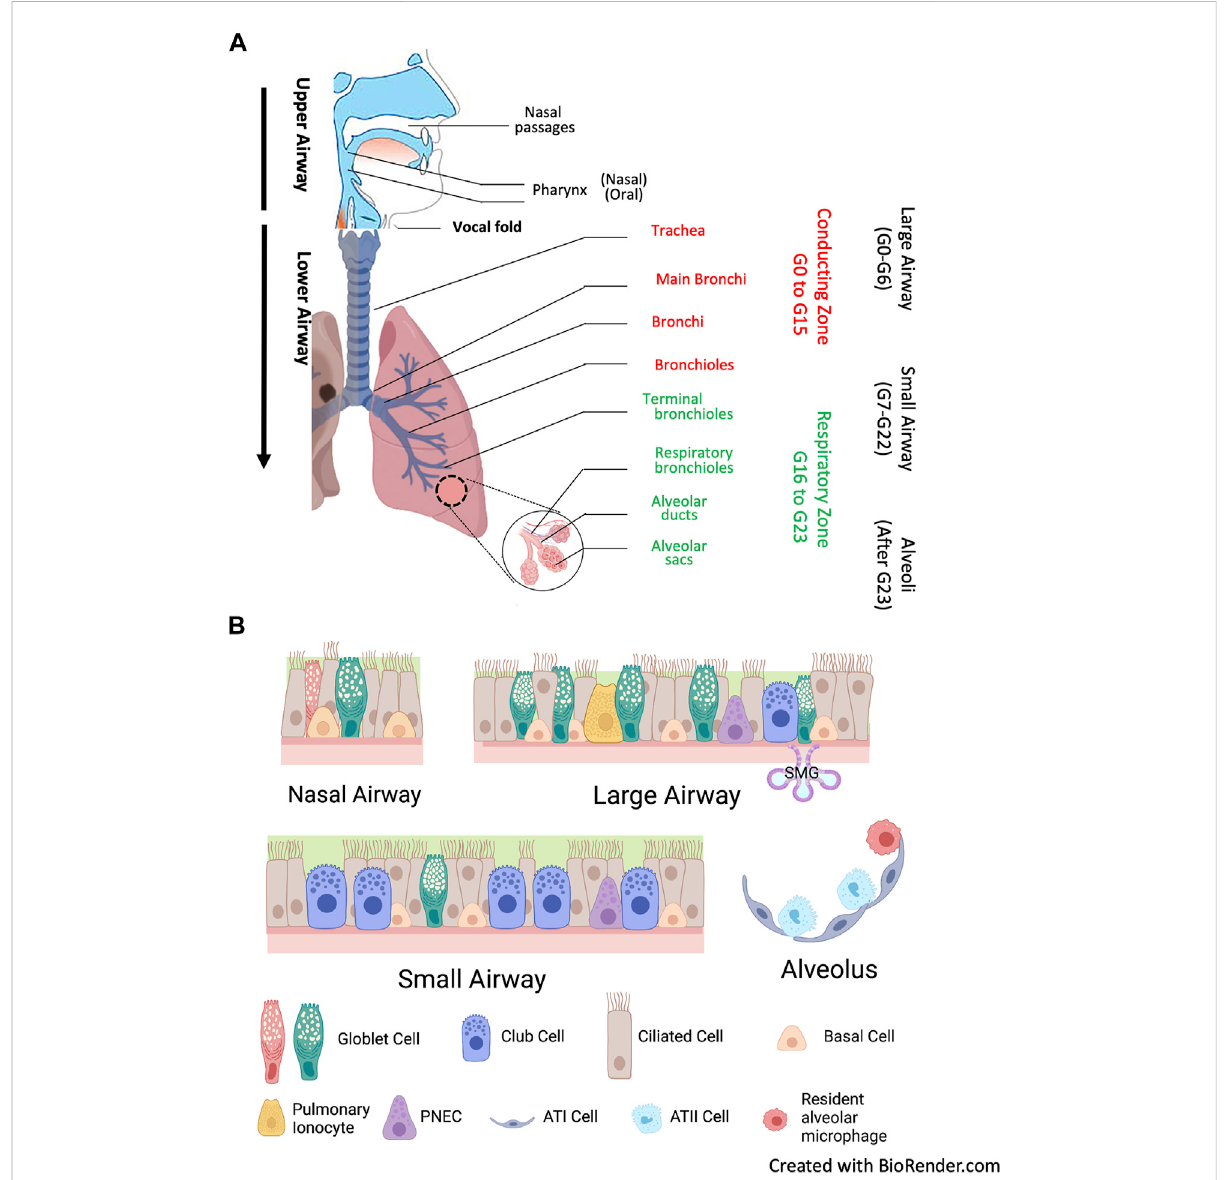
FIGURE 2 Humanairwaysandmajorairwayepithelialcelltypes. (A) Anatomy.Thehumanairwaysaredividedintotheupperairways,lowerairwaysandthe lung parenchyma. The upper airways include the nose and nasal passages, paranasal sinuses, the pharynx, and the portion of the larynx above the vocal folds (cords). The lower airways include conducting zone from generation (G) G0 to G16, and respiratory zone from G17 and beyond. The trachea andproximal bronchi(generationG0to G6)areconsideredaslarge airways.The smallairways aredistalbronchioleswhose diameter is smaller than 2mm, starting from G7 the terminal bronchioles in conducting zone to the respiratory bronchioles in respiratory zone. After G23, the airway epithelium merges with the alveolar epithelium with pneumocyte type I and type II cells (alveolar type I and II cells, ATI and ATII cells) in lung parenchyma. (B) Airway epithelium is a continuous cellular layer with epithelial cell populations and functions vary along the respiratory tree. It is pseudostrati fi edinthenasalandlargeairways,becomingcolumnarandcuboidalinthesmallairways.Submucosalglands(SMG)aremajorlyfoundin largeairways.Majorsurfaceepithelial celltypes arecolumnarciliatedcells, goblet cells,clubcellsandbasal cells. Theircompositionissimilarinlarge andsmallairways,butwithgraduallylessciliatedcells,andthesecretorycellsshiftfromgobletcellstothedome-shapedclubcells.Airwaybasalcells have the capacity to differentiate into the major cell types of the airways, and a subset of club cells can differentiate to ciliated cells and goblet cells. Pulmonary ionocytes express high level CFTR , but the mechanism by which they contributed to cystic fi brosis are still largely unknown. Ionocytes maybeabsentinthesmallairways.Pulmonaryneuroendocrine